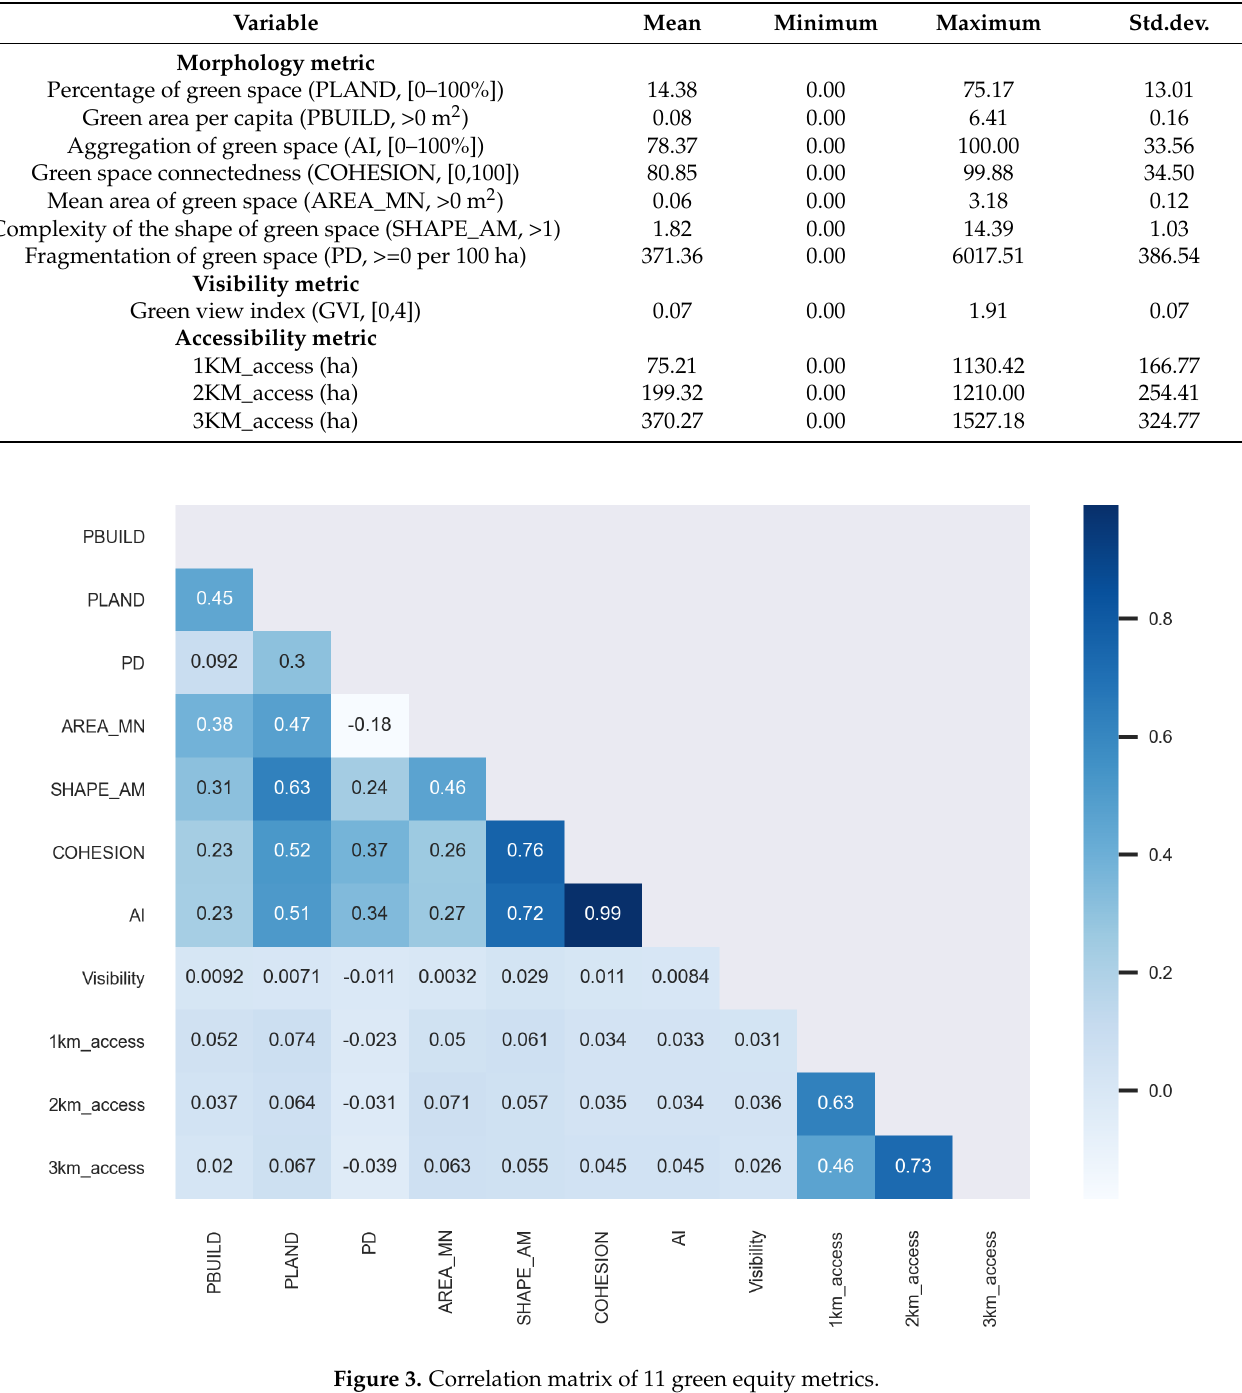
Figure 3. Correlation matrix of 11 green equity